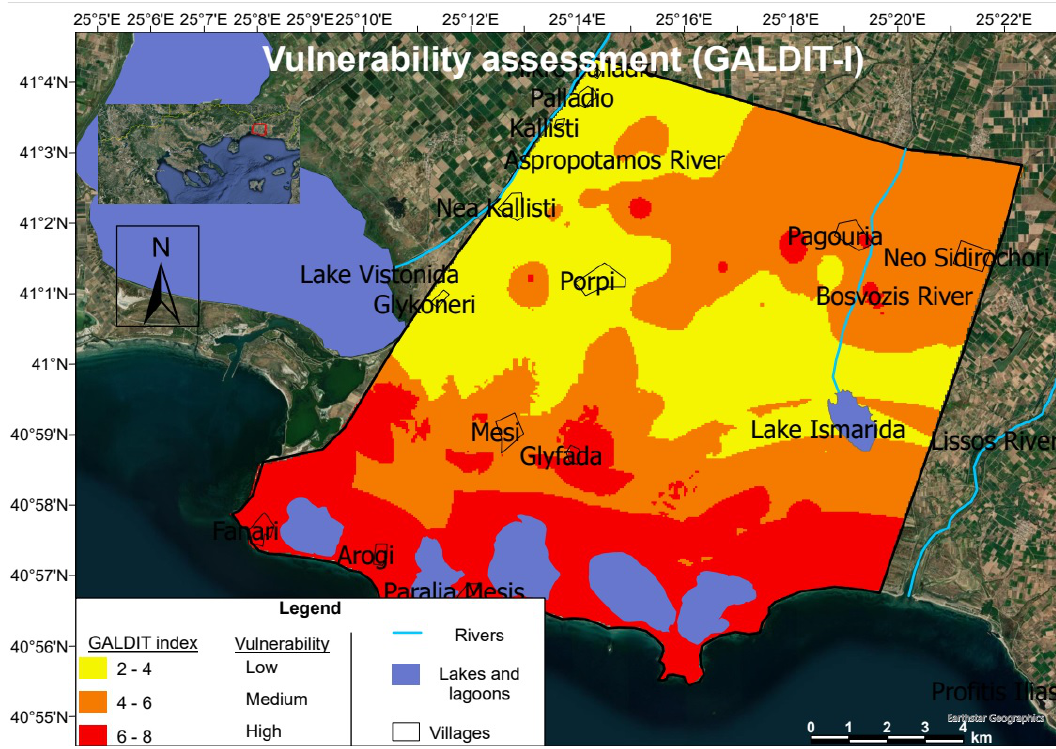
Figure 9. Calculation of GALDIT-I index and vulnerability assessment map.